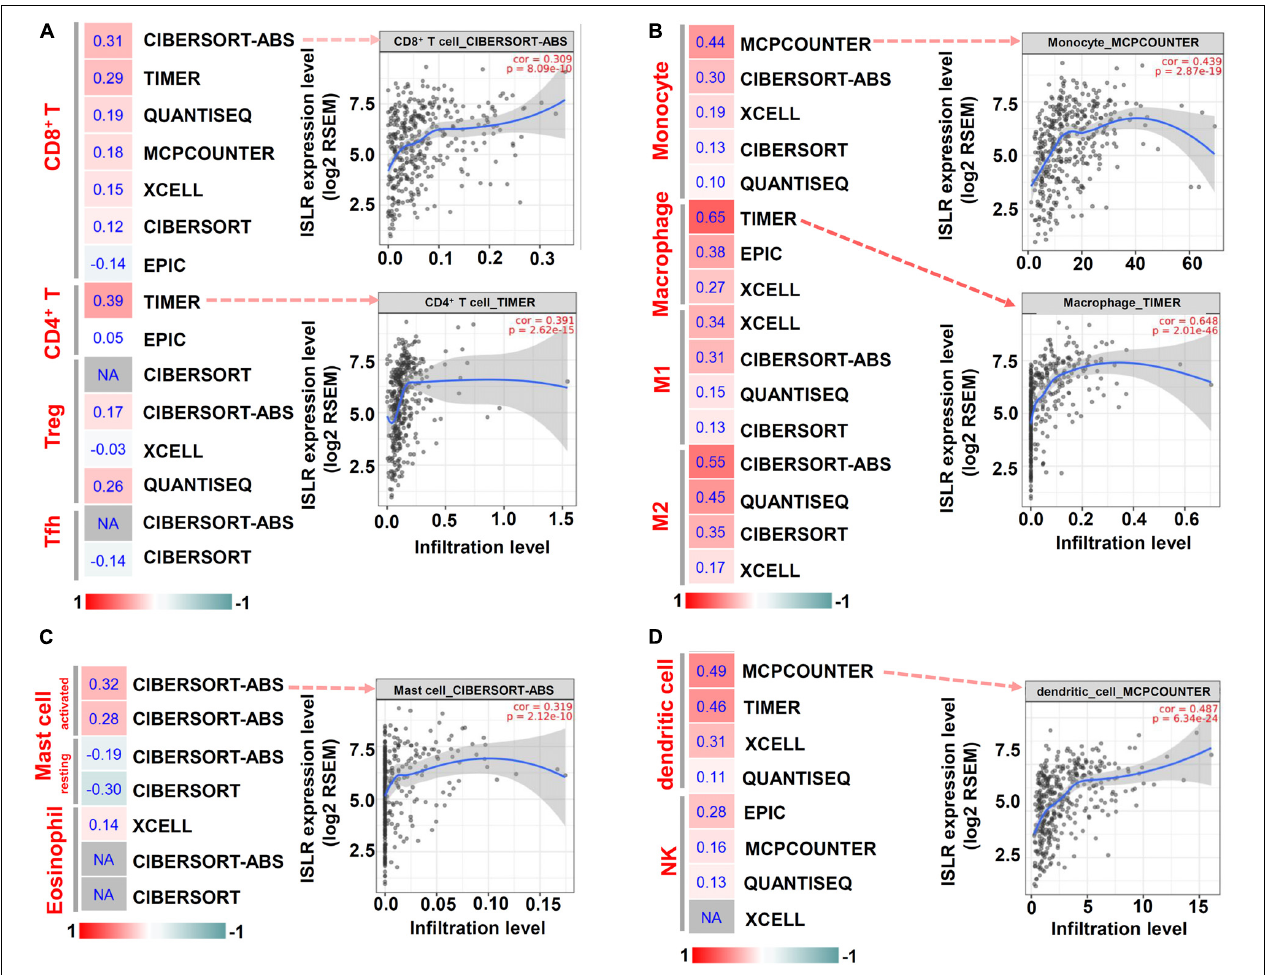
FIGURE 6 | Correlation between ISLR expression and the infiltration level of immune cells. The TIMER, CIBERSORT, CIBERSORT.ABS, QUANTISEQ, MCPCOUNTER, XCELL, and EPIC algorithms were applied for the immune infiltration estimations of CD8 + T cells, CD4 + T cells, Treg cells, and Tfh cells (A) ; Monocytes and macrophages (M1, M2 type) (B) ; mast cells and eosinophils (C) ; and dendritic cells and NK cells (D) . A heatmap with the purity-adjusted Spearman’s rho value and specific scatter plots are provided as examples. “NA” means a lack of an association between ISLR expression and the infiltration level of immune